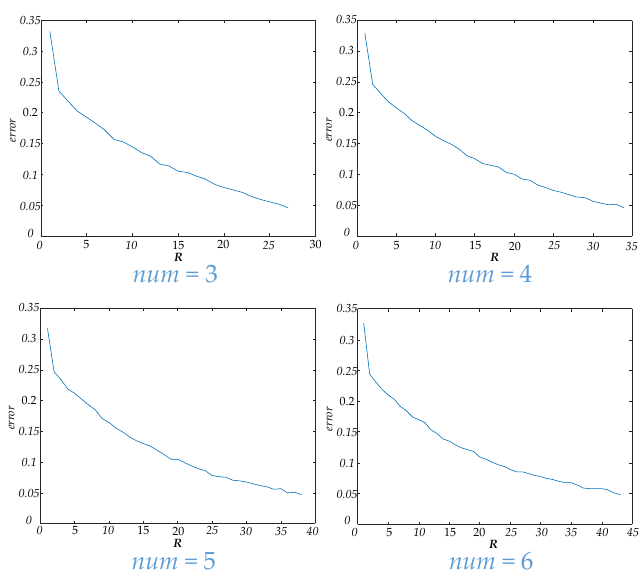
Figure 6. This figure shows the curves of R and error for different num values.